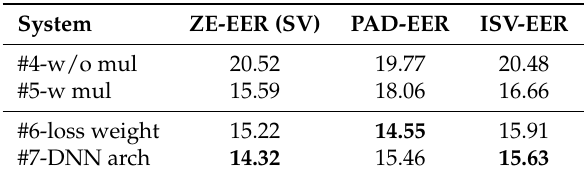
Table 5. Results of the proposed modular approach for the ISV task. Numbers in bold represent the best results.